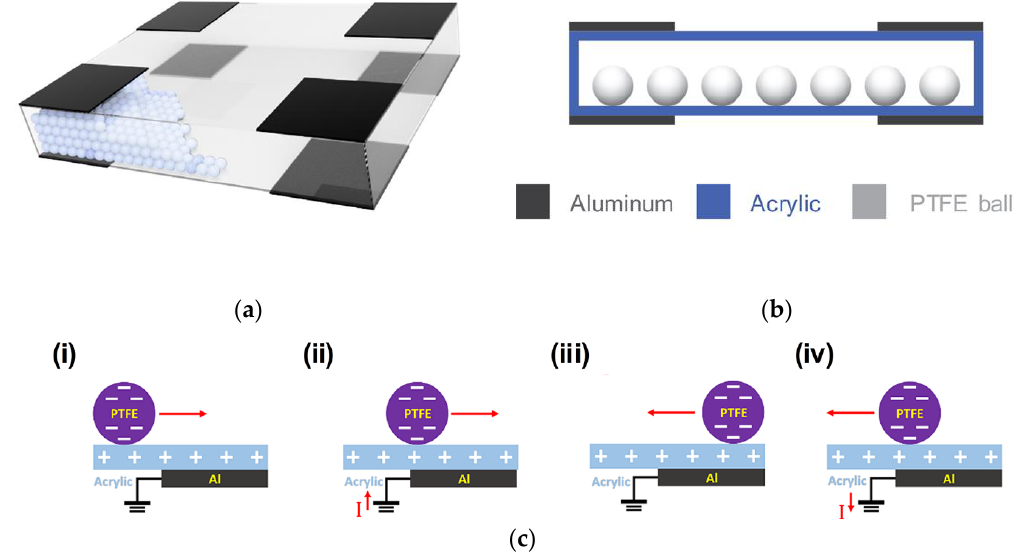
Figure 1. ( a ) Overall schematics of the orientation and tilt triboelectric sensor (OT-TES). ( b ) Cross- sectional view of the OT-TES. ( c ) Working mechanism of the